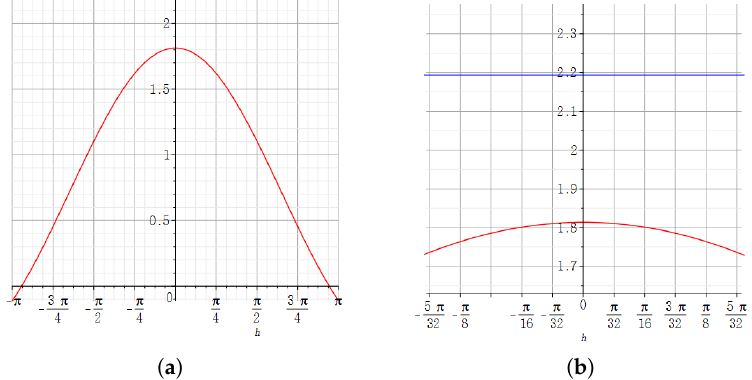
Figure 1. ( a ) The result obtained by using the Maple plot to see what the step derivative has according to the size of h . ( b ) In the graph of ( a ), the result of zooming in about h near zero. In ( a , b ), the red graph represents the j -step derivative of e z at z 0 according to the size of h , and the blue constant graph represents the absolute value of the derivative of e z at z 0 by the definition of the derivative for a complex